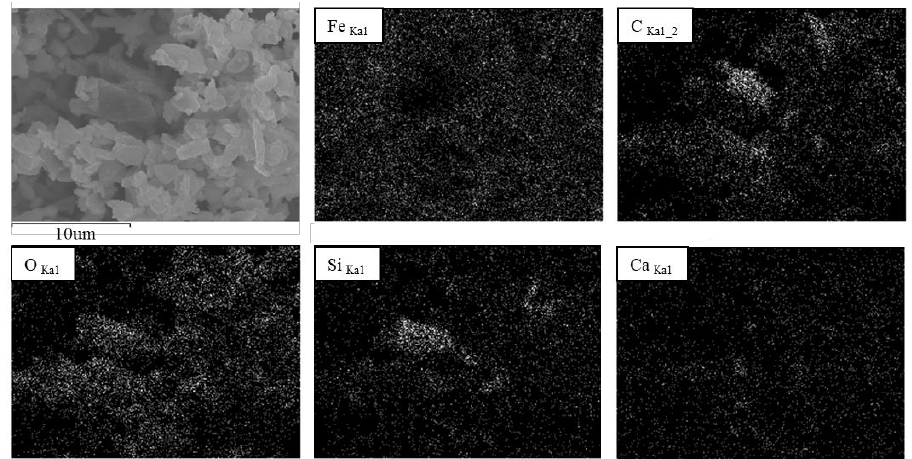
Figure 12. Elemental map of PM 2.5 at the M station.